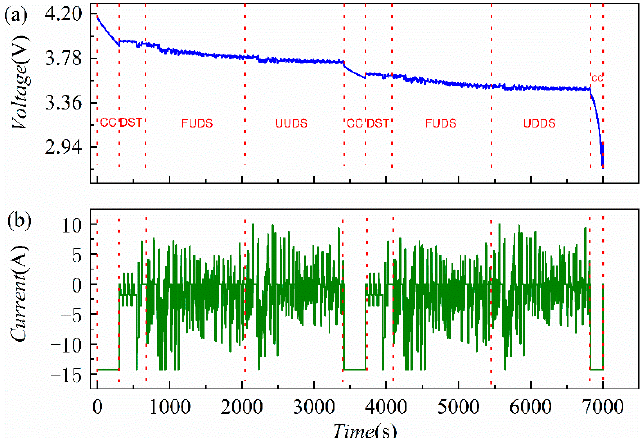
Figure 6. The curves of Time vs: ( a ) current; ( b ) voltage under combined condition.